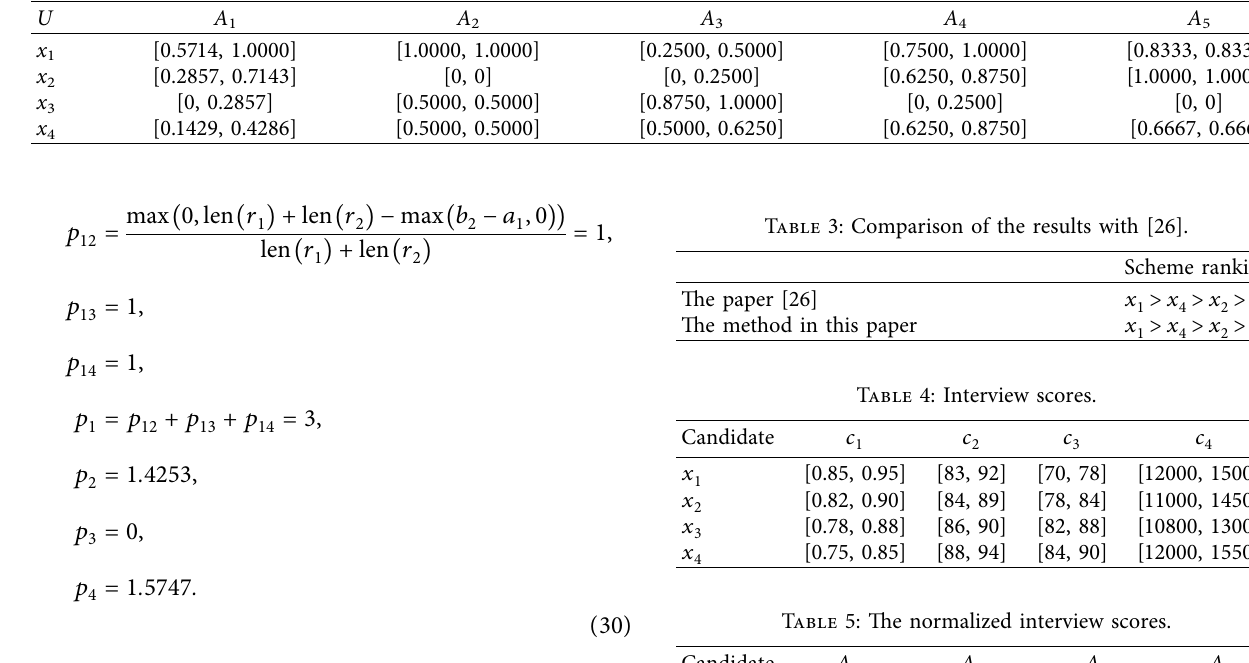
Table 2: Normalized decision matrix.